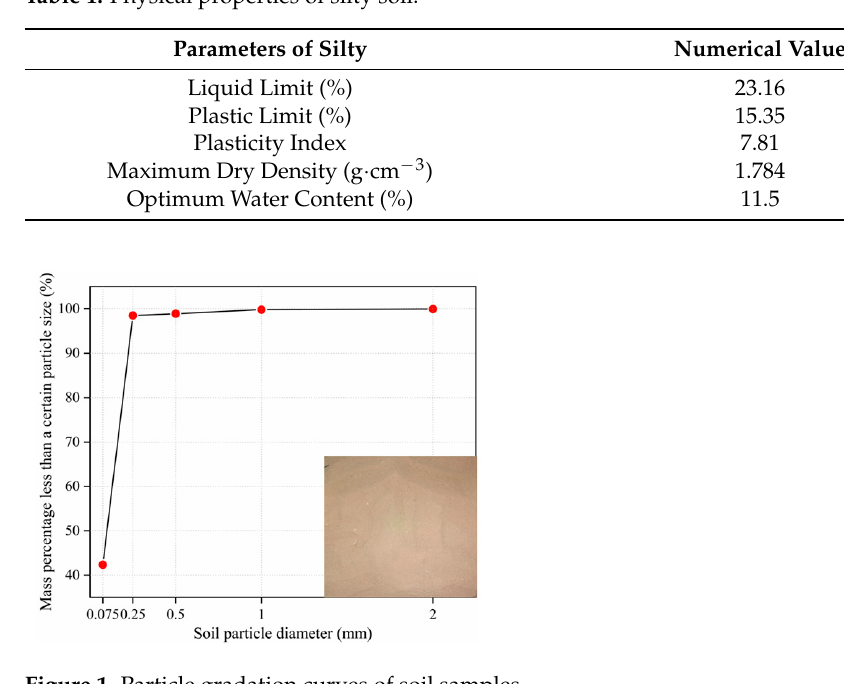
Table 1. Physical properties of silty soil.